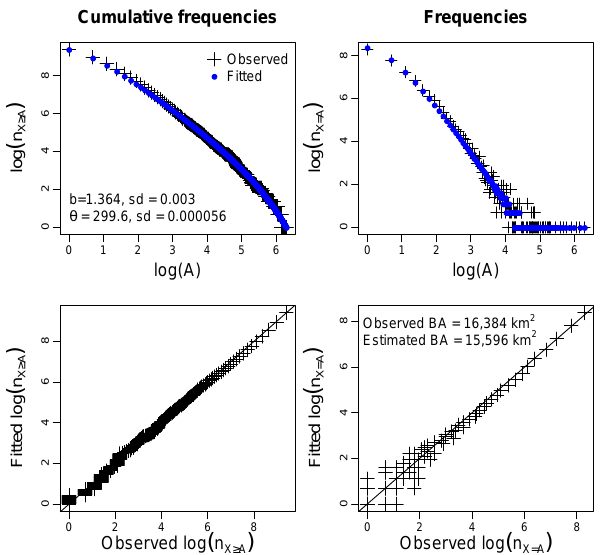
Fig. 2. Plots of the observed (black) and fitted (blue) cumulative frequency distribution (top left) and non-cumulative frequency dis- tribution (top right), with the corresponding plots fitted against ob- served values (with 1:1 lines, bottom row). Logarithmic axes are used for all plots. The burnt area values given in the bottom-right plot are the total observed and estimated burnt area over the whole study region.